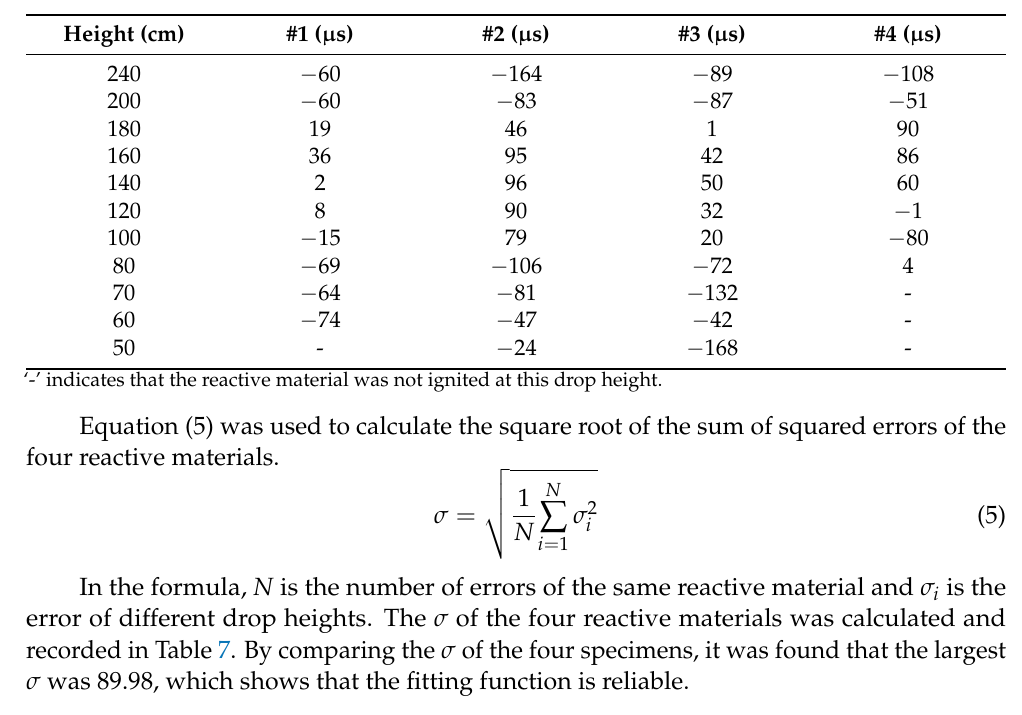
Table 6. The errors between the fitting value and the experimental value at different drop heights.